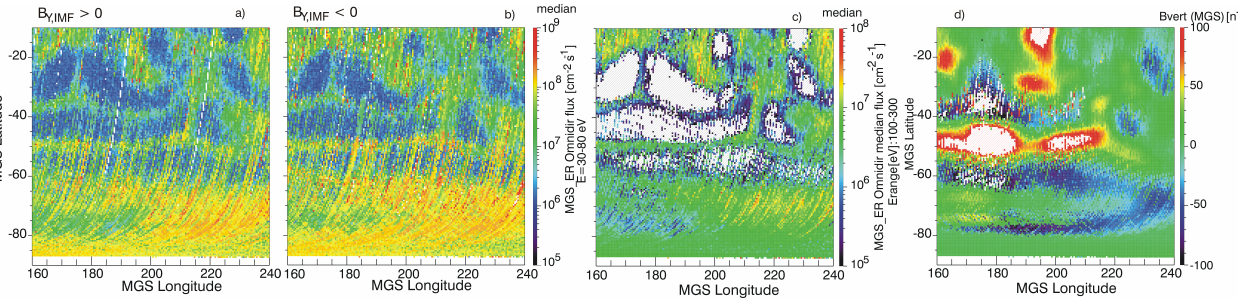
Fig. 12. (a, b) Precipitation patterns of median fluxes of the electrons with 30 <E e < 80eV measured on the MGS at h ∼ 400km at the positive and negative B y IMF , (c) precipitation pattern of electrons with 100 <E e < 300eV, (d) vertical component of the crustal magnetic field.